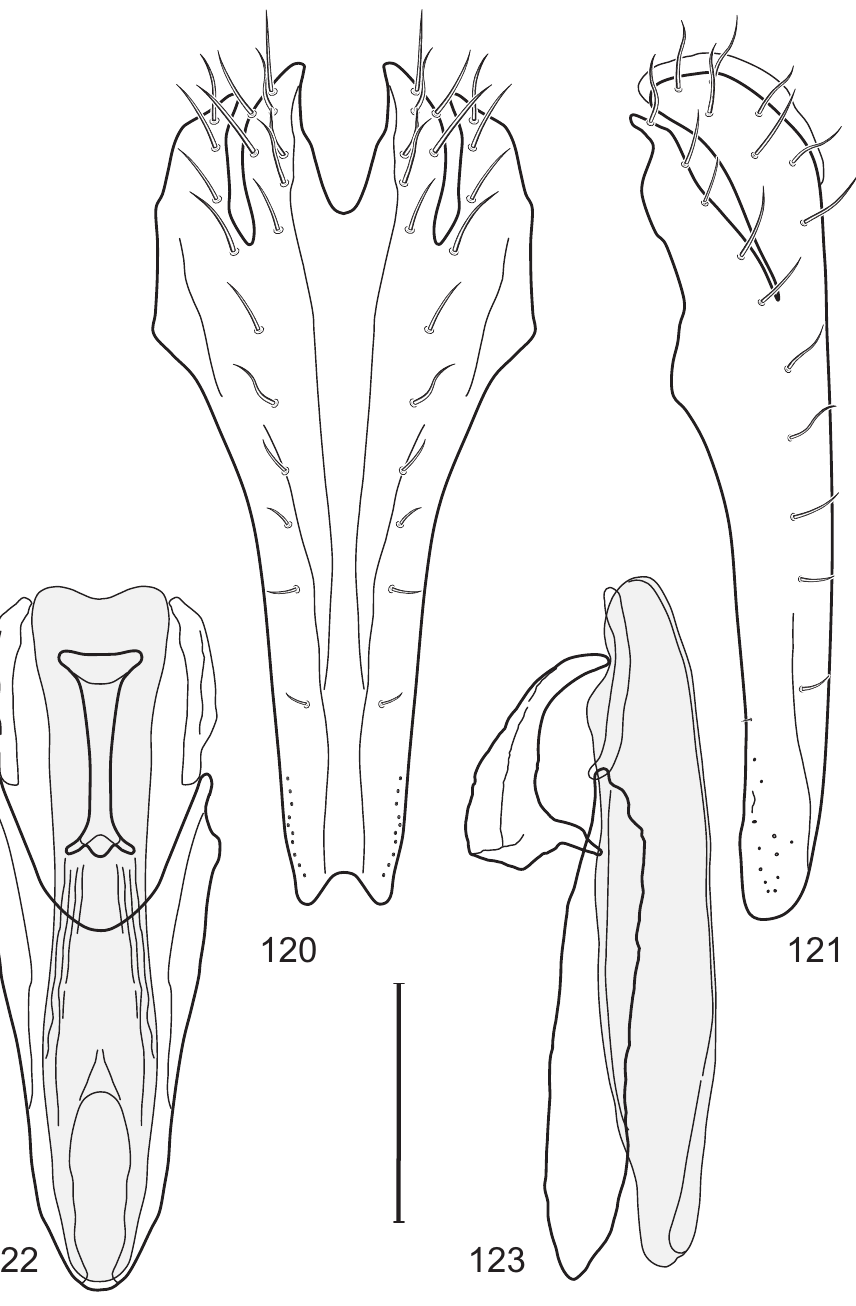
Figures 120–123. Hydrochasma simplicum sp. n. (Costa Rica. Cartago: Parque Nacional Barbilla, Río Dantas) 120 epandrium and cerci, posterior view 121 same, lateral view 122 internal structures of male terminalia (aedeagus [shaded], phallapodeme, gonite, hypandrium), ventral view 123 same, lateral view. Scale bar = 0.1